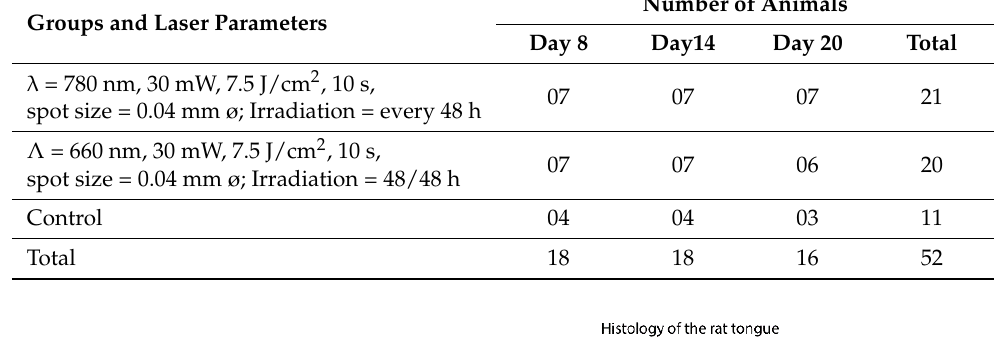
Table 1. Laser parameters and number of animals in each experimental period. Groups and Laser Parameters